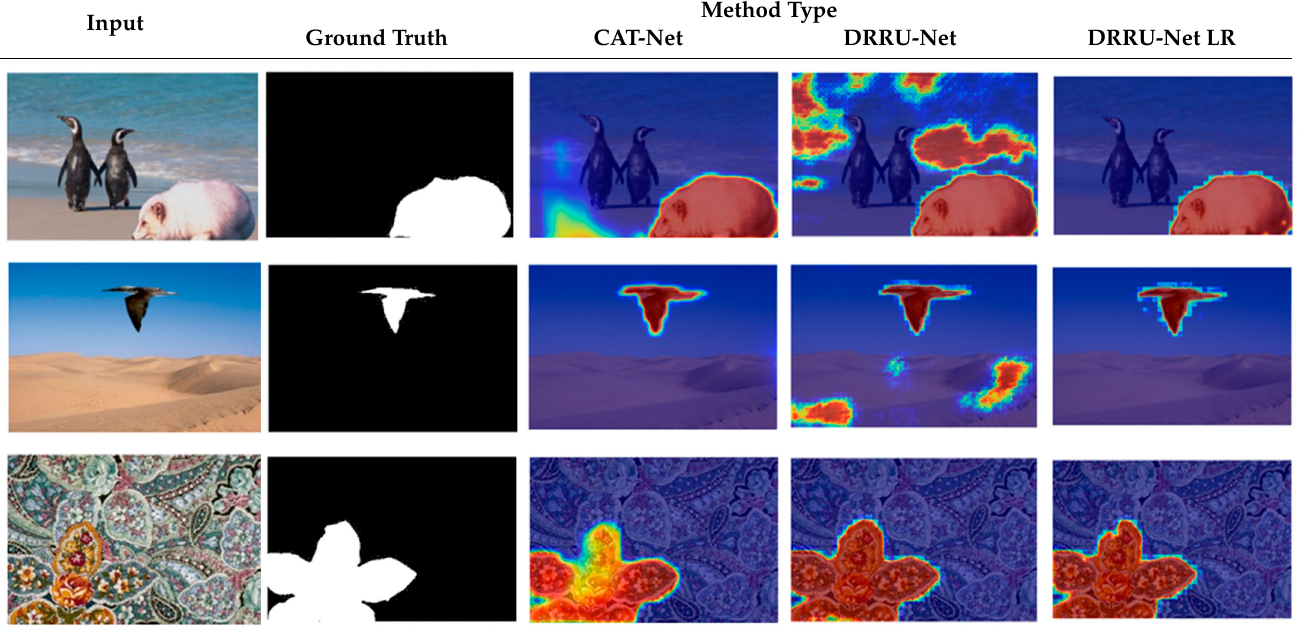
Table 4. Comparison of CAT-Net, DRRU-Net, and DRRU-Net LR forgery regions detection results.